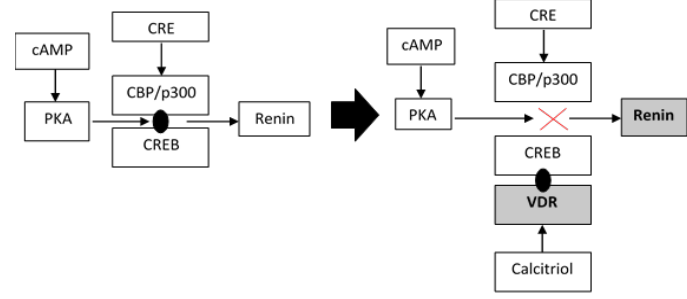
Figure 1. The Mechanism of Vitamin D Deficiency on Blood Pressure